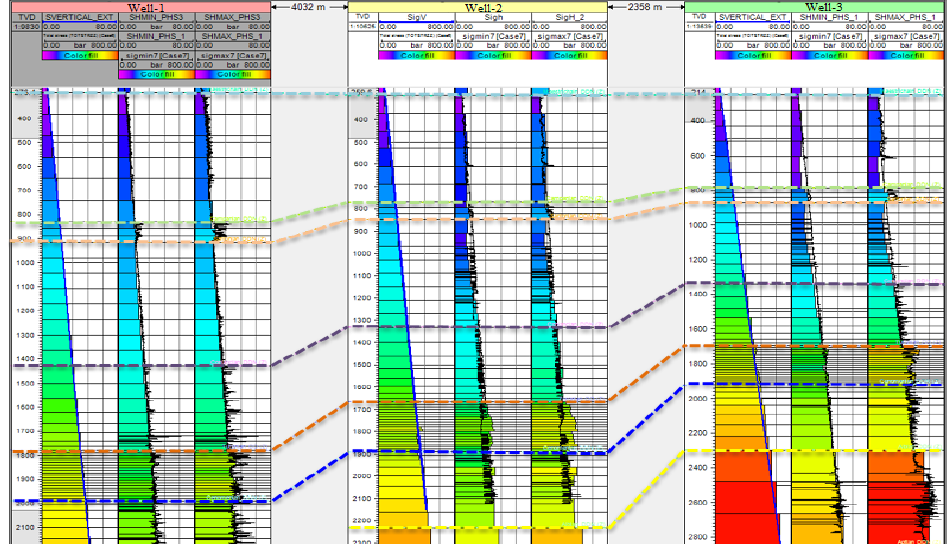
Figure 12. Comparison of the results of the 3D model (coloured blocks) and the results of the 1D model. The tracks of each well are, from left to right, as follows: vertical stresses (bar), maximum